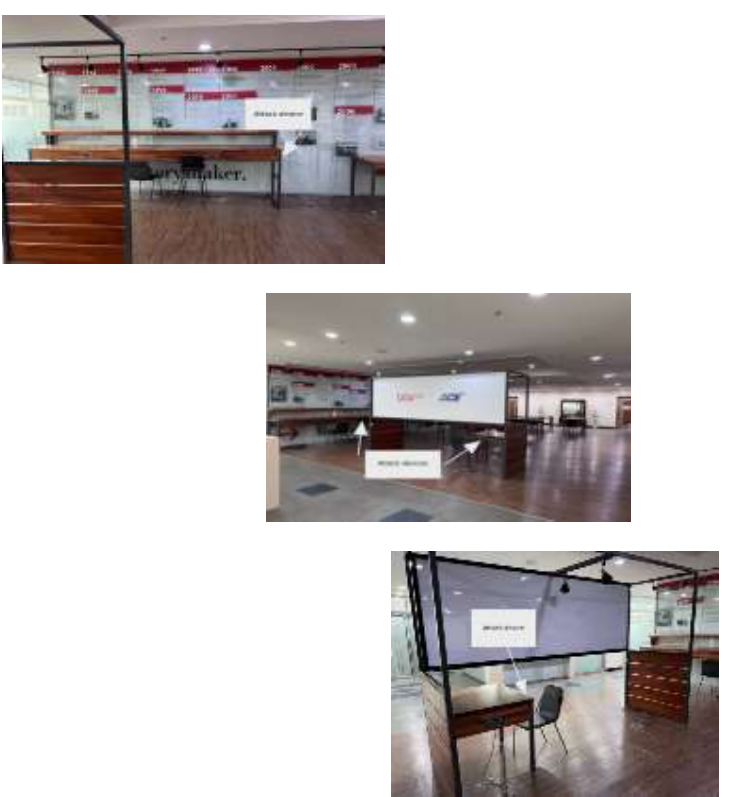
Figure 17. Attack Figure 17. Attack implementation. Table 6. Devices for the experiment: operating systems and device model. CableAttack compo- nents, including activation of the voice assistant (Activation), response from the device—listening to the request (Response).